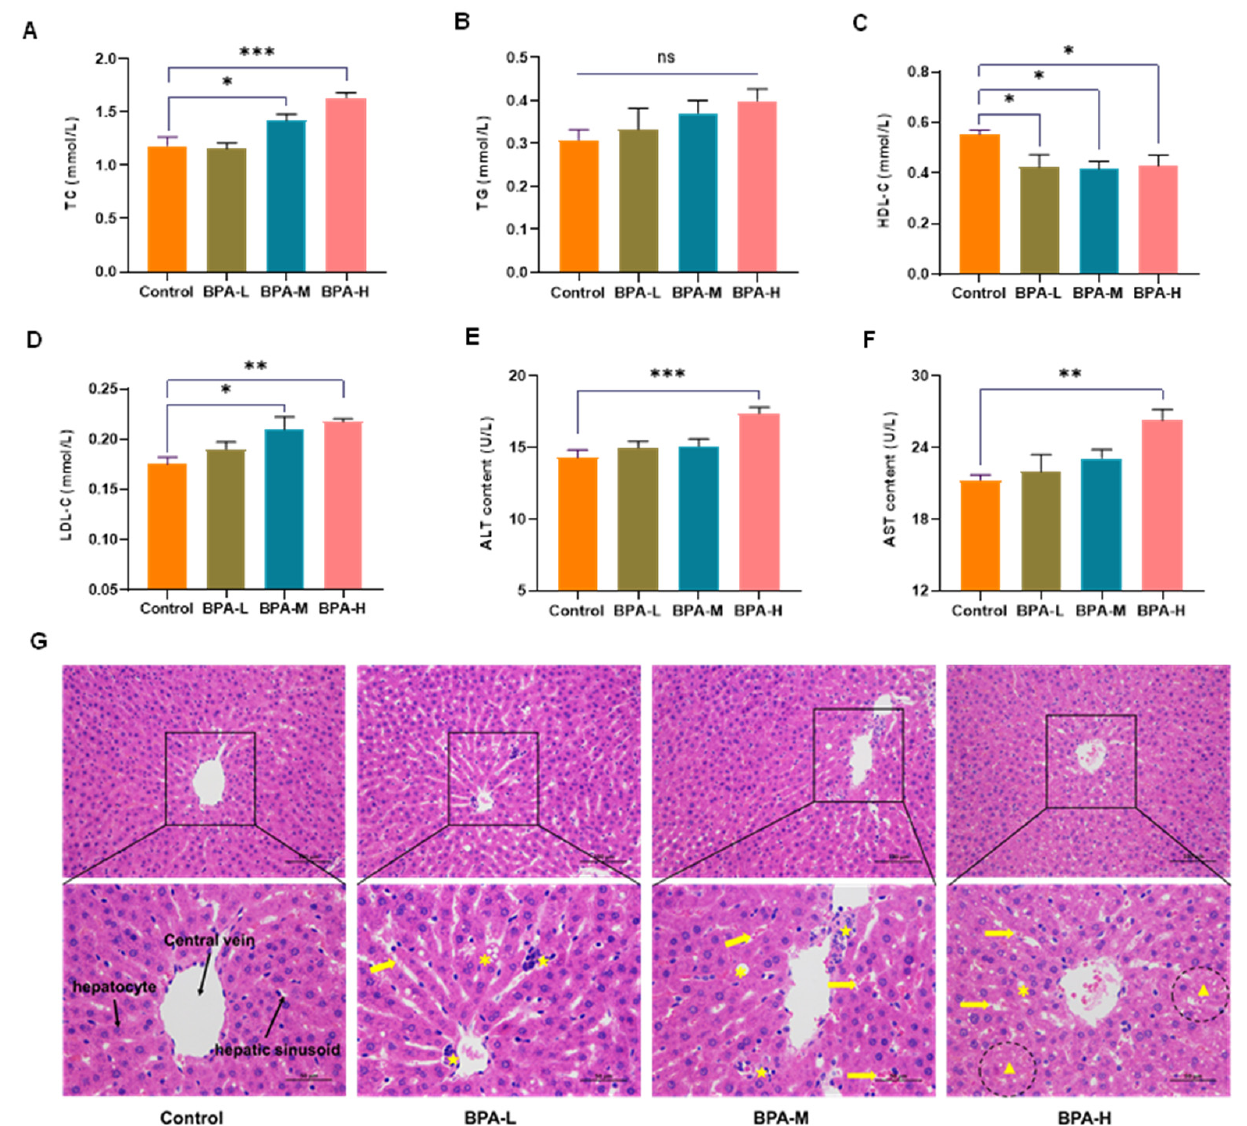
Figure 2. Effects of BPA on serum levels of ( A ) TC, ( B ) TG, ( C ) HDL-C, ( D ) LDL-C, ( E ) ALT, and ( F ) AST. These data were expressed as means ± SEM ( n = 8). * p < 0.05, ** p < 0.01 and *** p < 0.001 versus the Control. Histological sections of the liver were stained with hematoxylin-eosin (HE) (200×, 400×) ( G ). ✱ steatosis; Yellow arrows: sinusoidal dilatation and congestion; ★ infiltration of inflammatory cells; ▲ necrosis. ns: no significance.